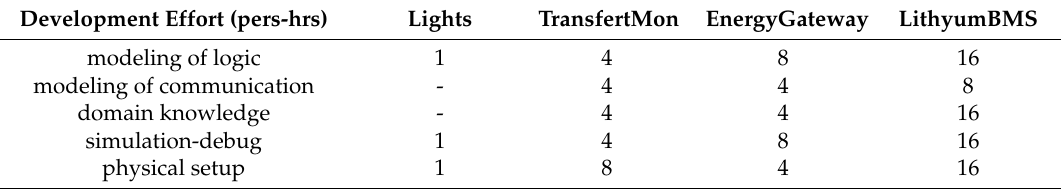
Table 4. Development effort in person-hours for the different